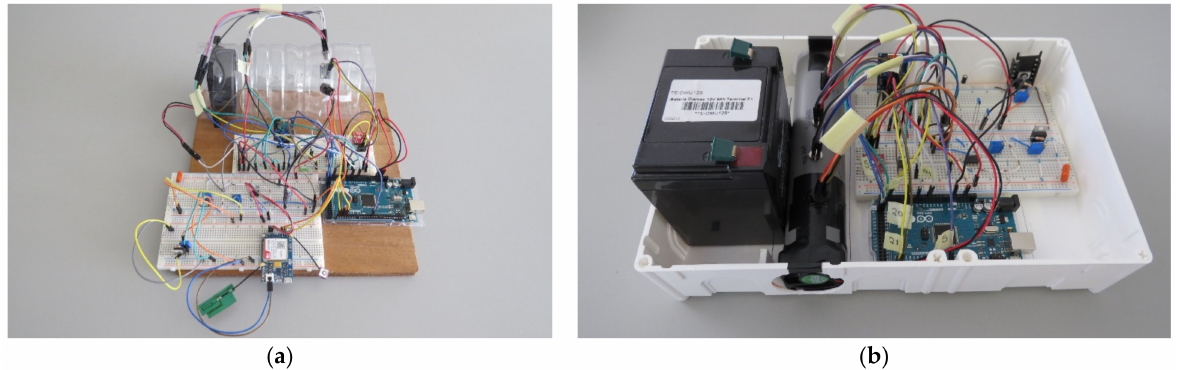
Figure 6. ( a ) System using breadboards with a fixed power supply; ( b ) portable system using a